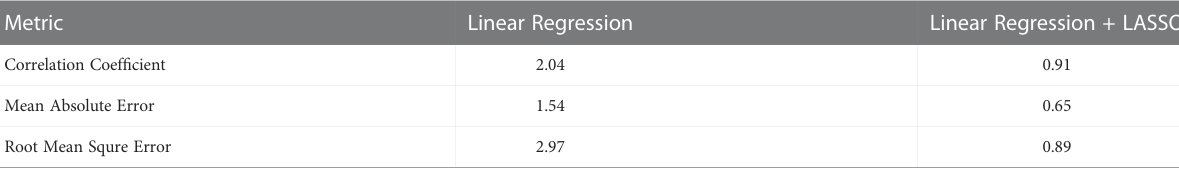
TABLE 11 Performance analysis and comparison of survival estimation model with LASSO and without LASSO